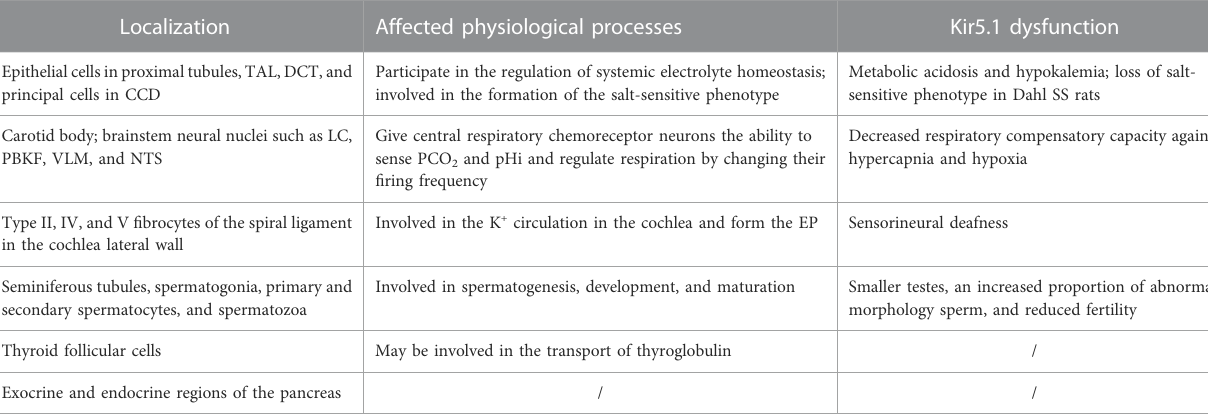
TABLE 2 The localization and involvement of Kir5.1 in physiological processes and Kir5.1 dysfunction.